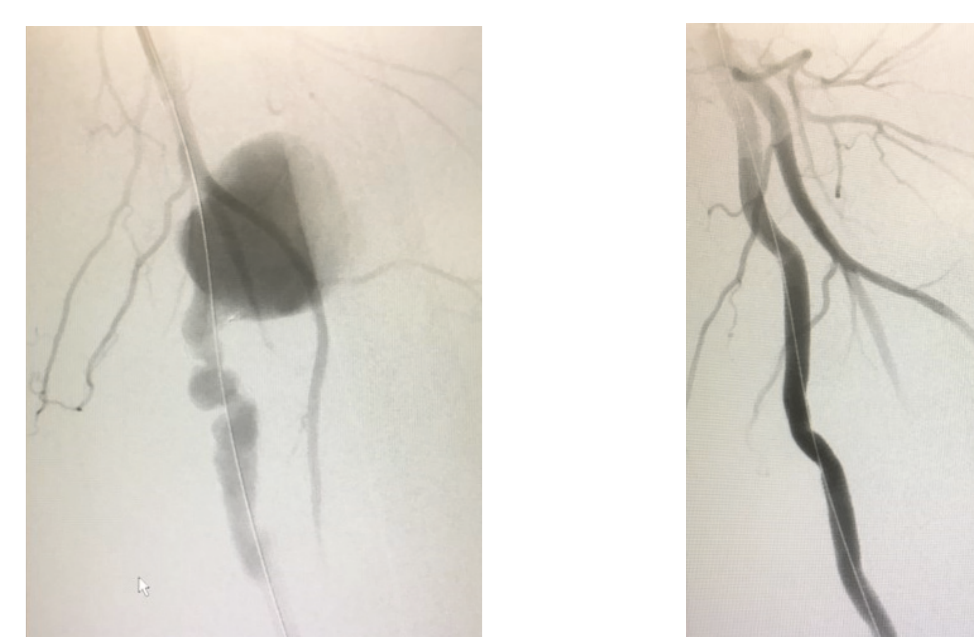
Figure 4: Intraoperative angiogram showing the left superficial femoral artery pseudoaneurysm with wire in place.